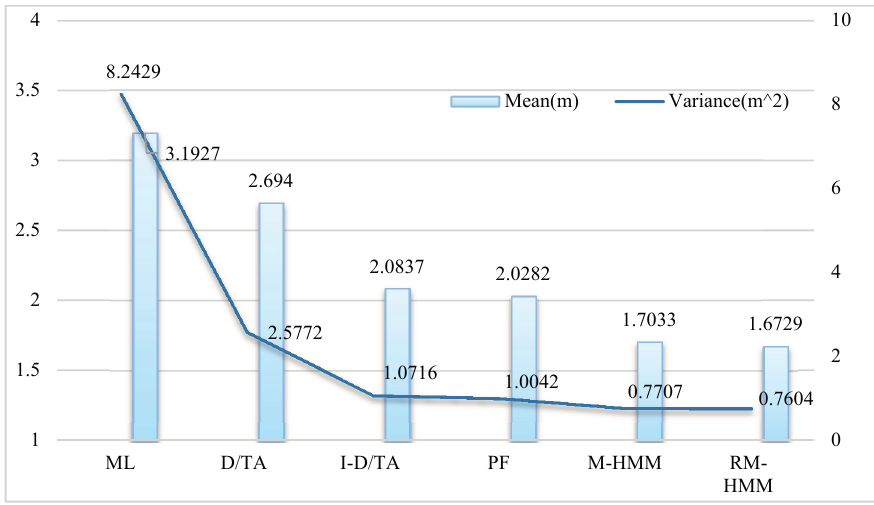
Figure 14. Means and variances of the six algorithms.